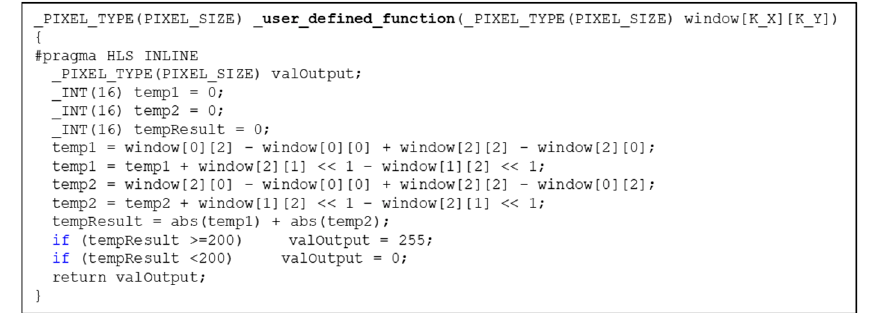
Figure 2. The core function for the Sobel operation when using a skeleton SCP.